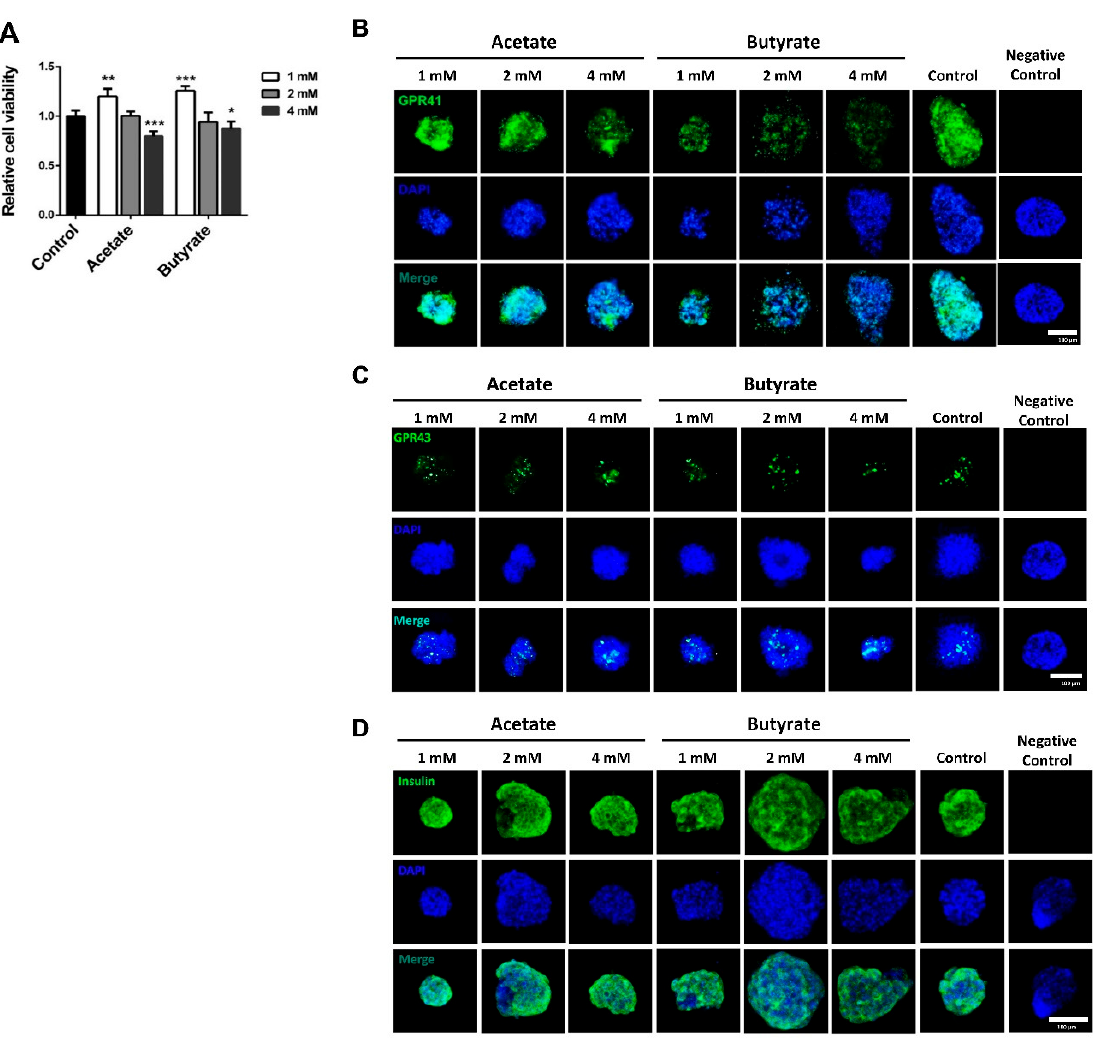
Figure 1. E ff ects of acetate and butyrate on the viability and expression of G protein-coupled receptor 41 (GPR41) and GPR43 in human islets. Human islets were incubated with 1, 2, or 4 mM acetate or butyrate for 24 h. Cell viability was quantified with water soluble tetrazolium salt 1 (WST-1) assay ( A ), and GPR41 ( B ), GRP43 ( C ), and insulin (D ) protein were visualized with immunofluorescence. Results are plotted as mean ± SEM ( n = 5, di ff erent donors). Islets incubated with only fluorescent-conjugated second antibody served as negative control. The statistical di ff erences were quantified using one-way ANOVA analysis with Newman–Keuls multiple comparisons test (* p < 0.5, ** p < 0.01, *** p < 0.001, compared to the untreated control group). Scale bar denotes 100 µ